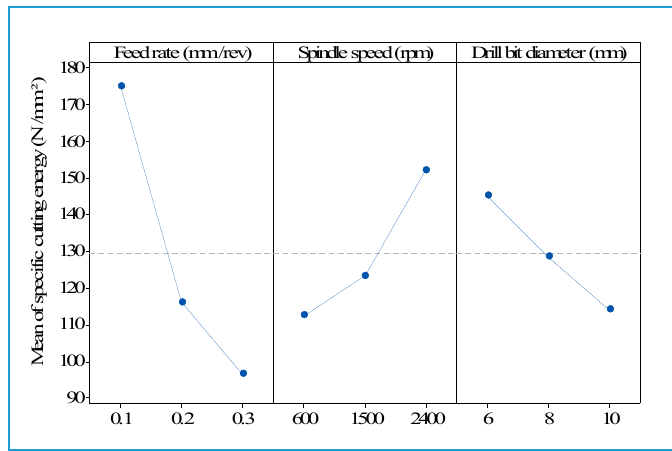
Figure 6. Main e ff ects plot for specific cutting energy related to thrust Figure 6. Main effects plot for specific cutting energy related to thrust force.